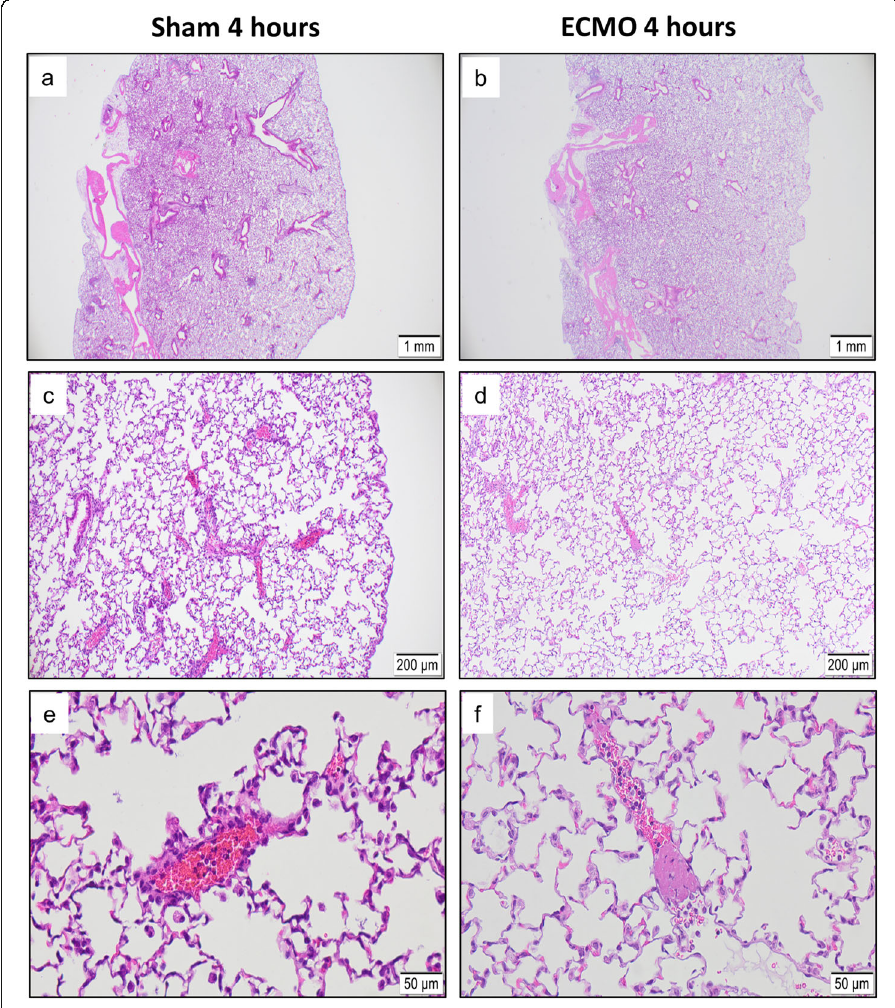
Fig. 6 Effect of ECMO treatment on lung histology. Shown are representative images of animals in either the sham ( a , c , e ) or ECMO oxygenation group ( b , d , f ) at the end of the procedure. Both groups showed normal bronchial and vascular architecture and normal general lung histology. Interestingly, animals treated with 4-h ECMO oxygenation frequently showed peripheral small vessel coagulopathy. Original magnifications × 2 ( a , b ), × 10 ( c , d ), and × 40 ( e , f